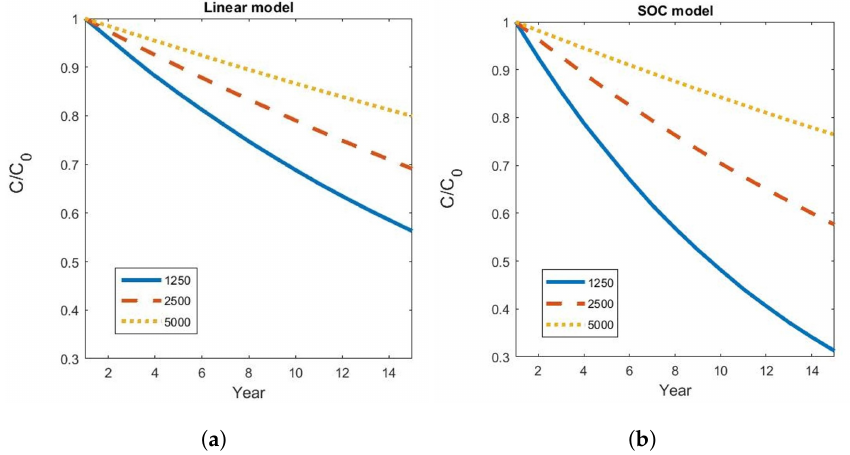
Figure 10. Capacity degradation as a function of years, for different battery life durations and for ( a ) LM and ( b ) SOCM. Solid blue line: 1250 cycles; red dashed line: 2500 cycles; yellow dotted line: 5000. The trend is polynomial of degree 2 in all the